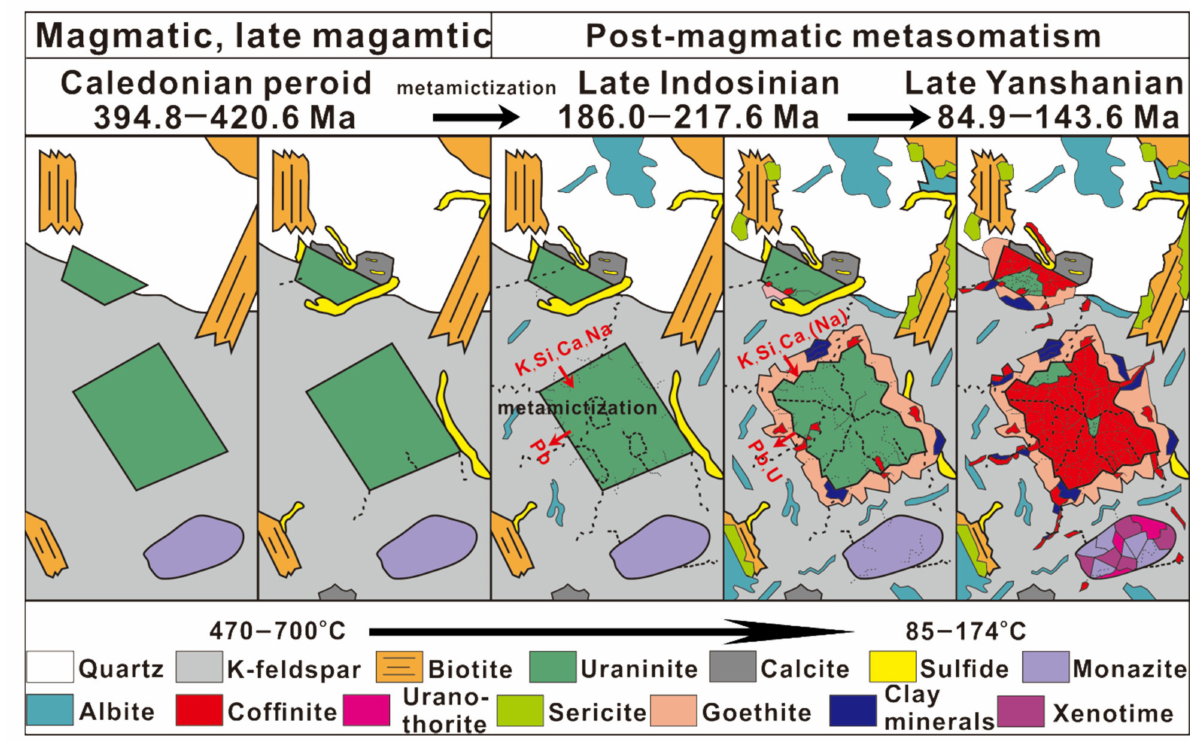
Figure 11. A model showing the uraninite evolution from magmatic crystallization through multiple hydrothermal alterations combined with metamictization processes in the Guangshigou